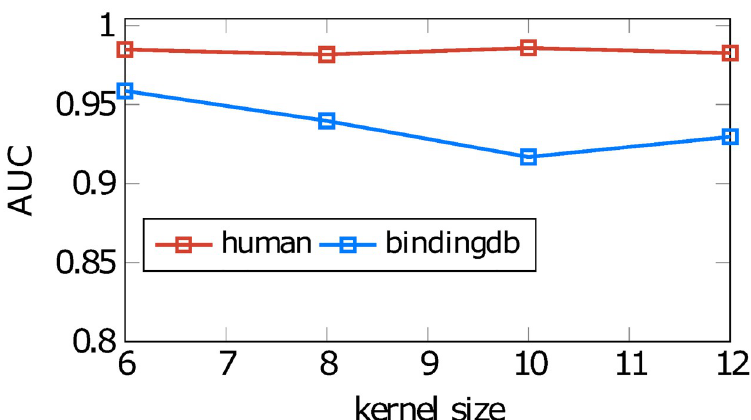
Fig 5. Performance of our model on two datasets, human and bindingdb , when it is trained with different 1D-CNN kernel sizes.